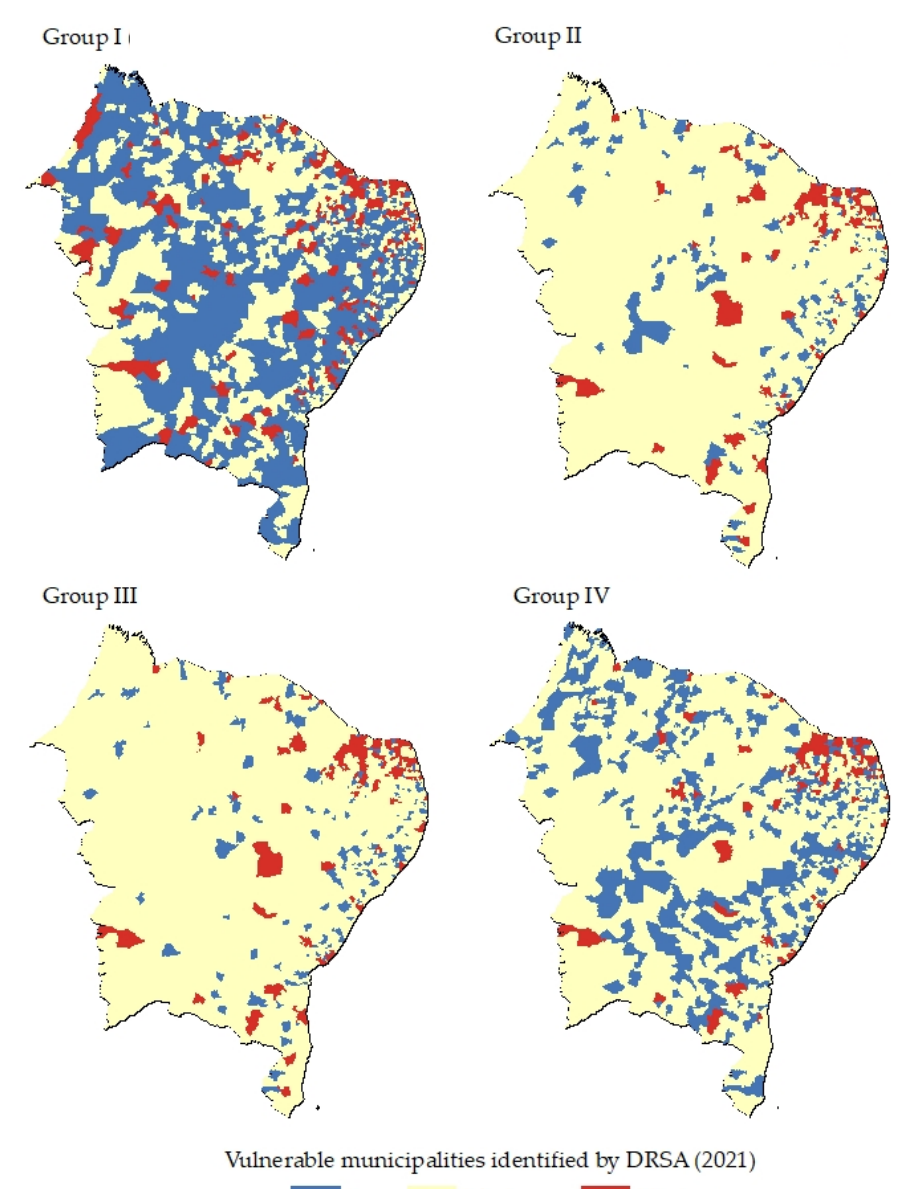
Figure 6. Classification results from DRSA for 2021 cases registered in 2021. Each group describes the classification from DRSA decision rules, considering the reference examples. Table 10. Distribution of municipalities for the vulnerable classes for groups observed in 2020 and 2021